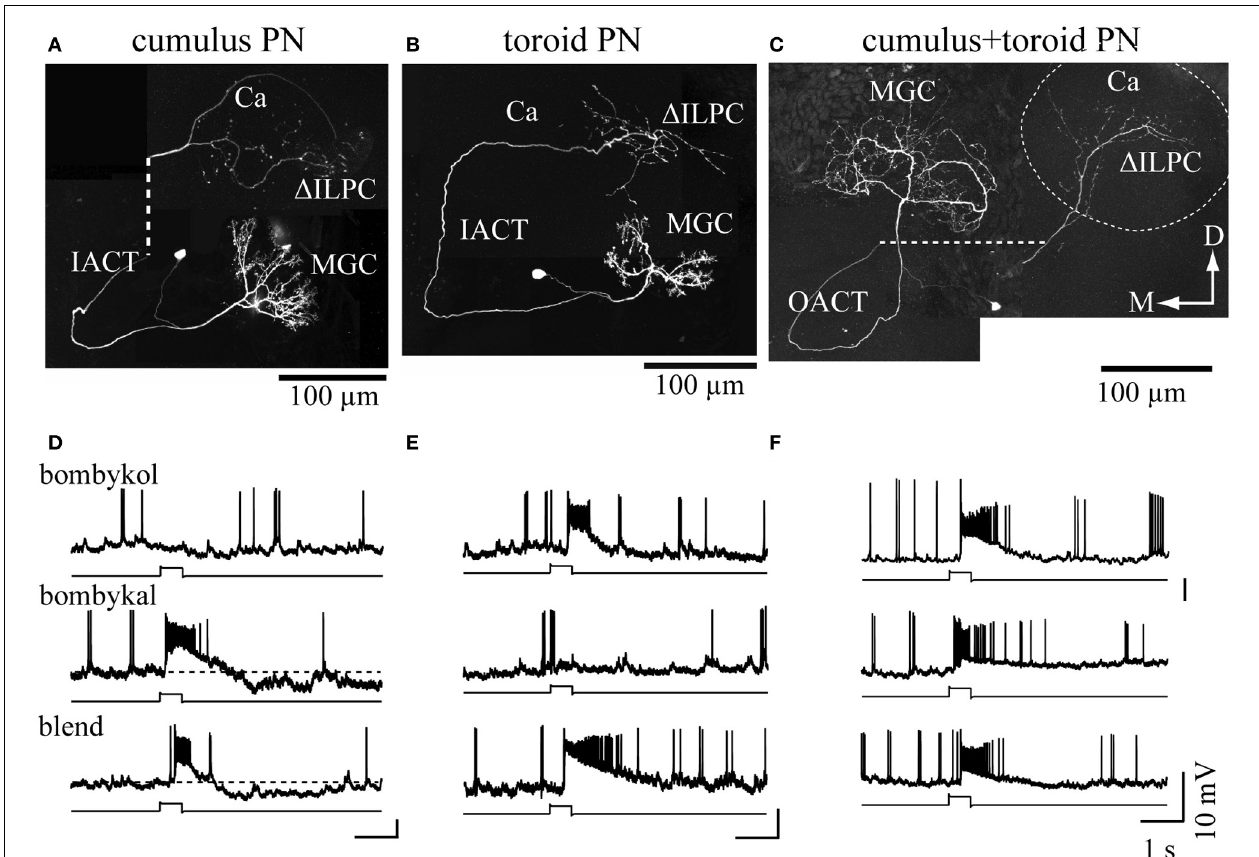
FIGURE 4 | Combinatorial representation of pheromones in the macroglomerular complex in the antennal lobe. (A–C) The morphologies of projection neurons innervating the cumulus (A) , toroid (B) , and both subdivisions (C) . The dashed line in (A) and (C) links processes that were separated to reveal the structures of branches that overlapped in situ . The dashed circle in (C) indicates the area of calyx of the mushroom body. (D–F) . The physiology of the projection neurons innervating the macroglomerular complex. The response properties shown in (D–F) correspond to (A–C) , respectively. Changes in the membrane